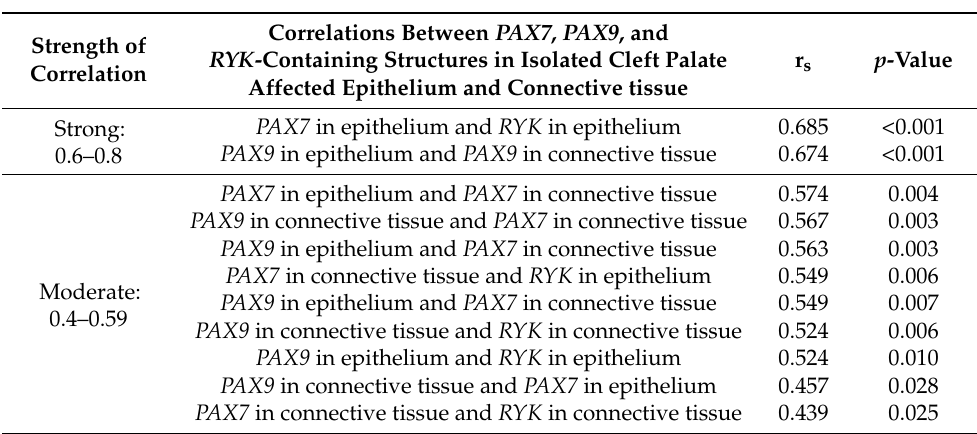
Table 4. Correlations between paired box 7 ( PAX7 ), paired box 9 ( PAX9 ), and receptor-like tyrosine kinase ( RYK ) immunopositive structures in isolated cleft palate affected tissue based on Spearman’s rank correlation coefficient calculation (r s —Spearman’s rho